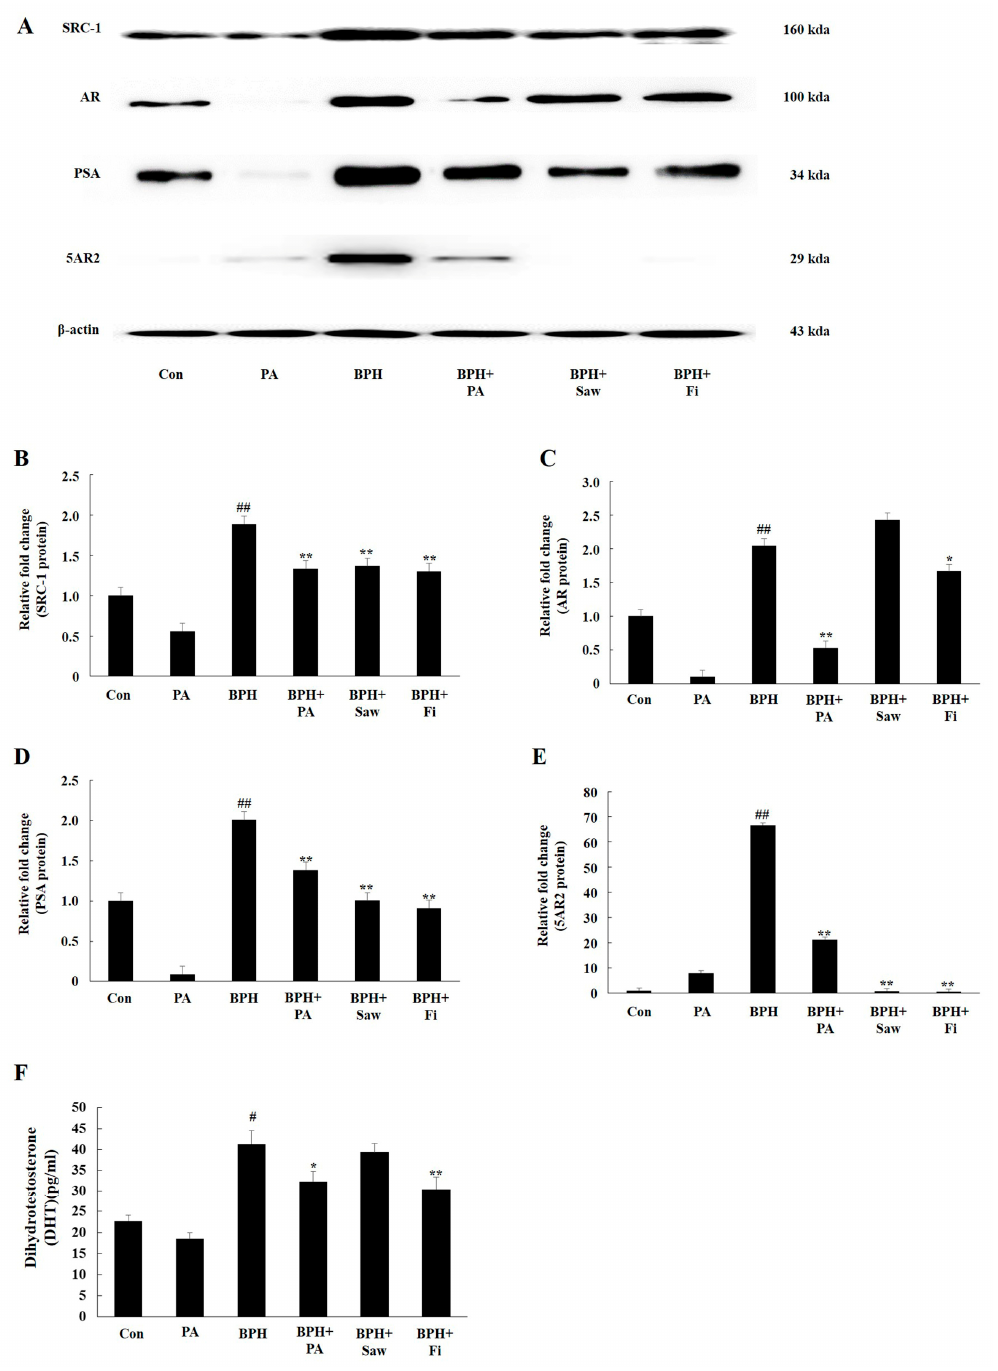
Figure 5. Effects of PA on the expression levels of the 5AR2, AR, SRC1, and PSA proteins in prostate tissues from rats with TP-induced BPH and the serum DHT levels. ( A ) Representative Western blot showing the bands of 5AR2, AR, SRC1, and PSA. ( B ) 5AR2 expression levels in the samples from the rats in each group. ( C ) AR expression levels in the samples from the rats in each group. ( D ) SRC1 expression in the samples from the rats in each group. ( E ) PSA expression in the samples from the rats in each group. ( F ) Serum DHT levels, as quantified by ELISA. Abbreviations: Con, corn oil, s.c. and D.W.-treated rats; PA, corn oil, s.c. and PA 100 mg/kg-treated rats; BPH, TP, s.c. and D.W.-treated castrated rats; BPH+PA, TP, s.c. and PA 100 mg/kg-treated castrated rats; BPH + Saw, TP, s.c. and saw palmetto 100 mg/kg-treated castrated rats; BPH + Fi, TP, s.c. and Fi 1 mg/kg-treated castrated rats. The data are expressed as the means ± SEMs. # p < 0.05 and ## p < 0.01, compared with the Con group; * p < 0.05 and ** p < 0.01, compared with the BPH group.